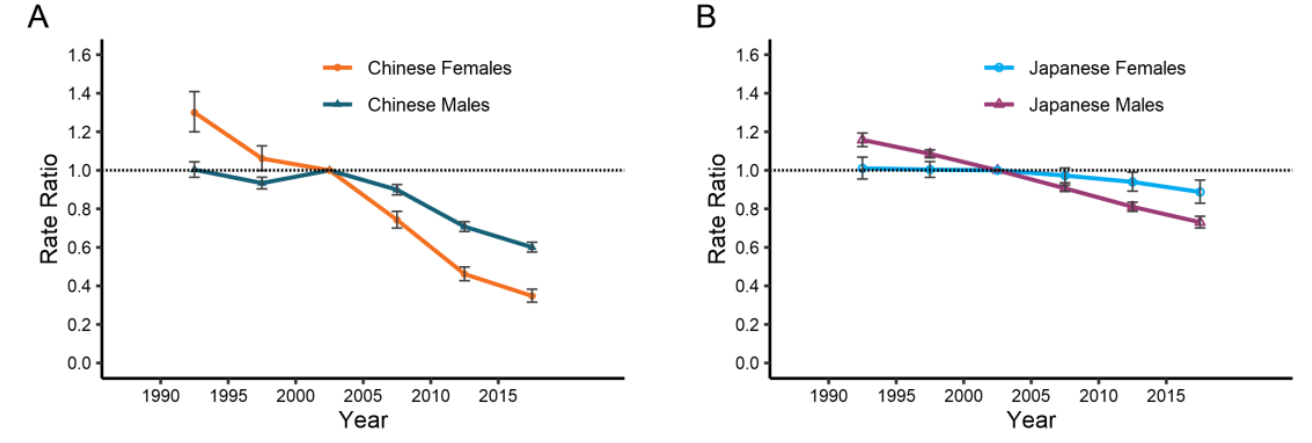
Figure 6. Period effects of esophageal cancer mortality by genders in China ( A ) and Japan ( B ). The relative risk of each period compared with the reference period (2000–2004) adjusted for age and nonlinear cohort effects and the corresponding 95% CI.